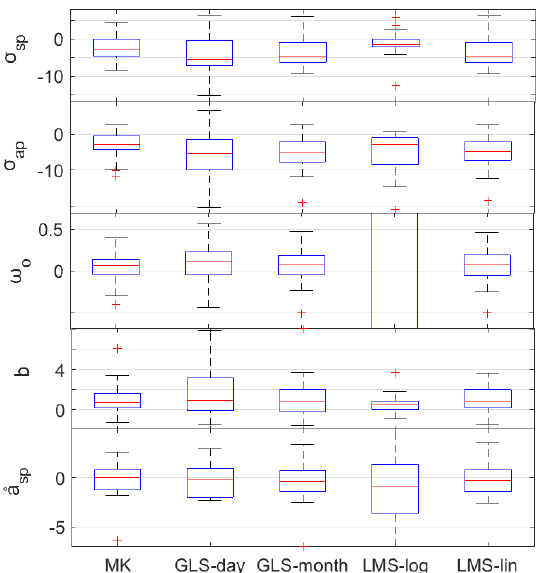
Figure 17. Median, interquartile ranges and whiskers of the slopes in %yr − 1 computed by the five methods for the scattering coef- ficient, the absorption coefficient, the single scattering albedo, the backscattering fraction and the scattering Angström exponent. The outliers are not always visible in the figure for the purpose of